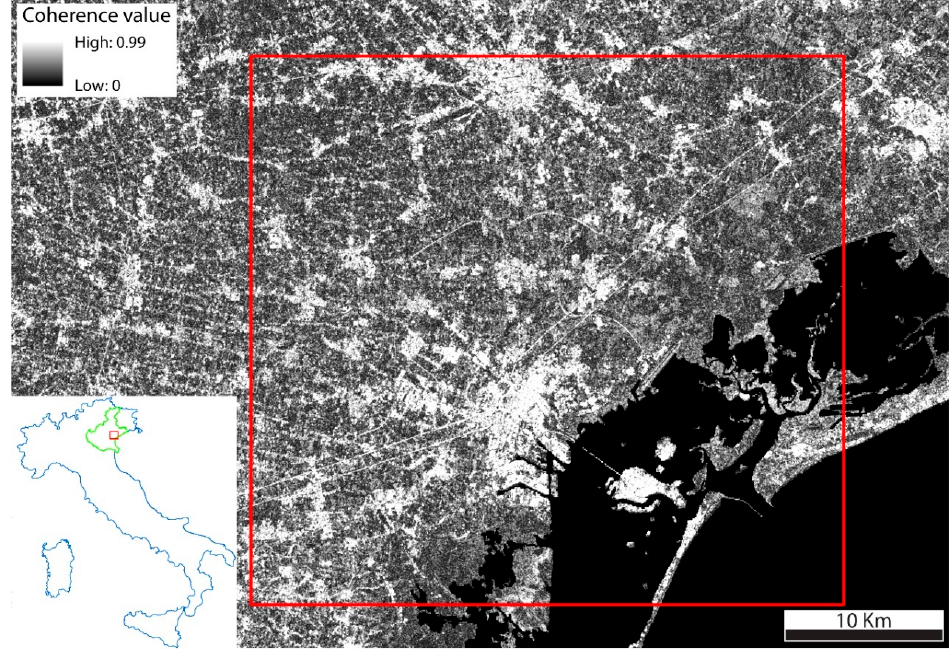
Figure 2. Coherence image of the Venice area, within the Veneto Region, represented in the bottom left frame with its green border within the Italian border (in red the study area). We produced this image from two Sentinel-1A images acquired on 01 April 2019 and 20 March 2019 (VH polarization only). In this sample area, we selected sub-swath number 2 (IW2) and bursts 5–9. Urban areas appear distinctively brighter than all other land cover types, with coherence value generally greater than 0.7.